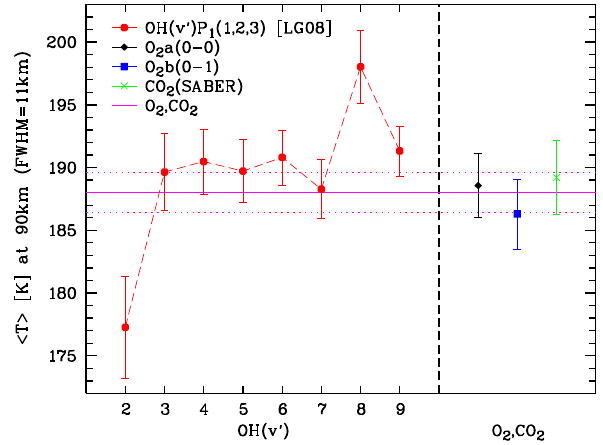
Figure 14. Same plot as Fig. 13 except for OH T rot based on the molecular parameters of van der Loo and Groenenboom (2007,